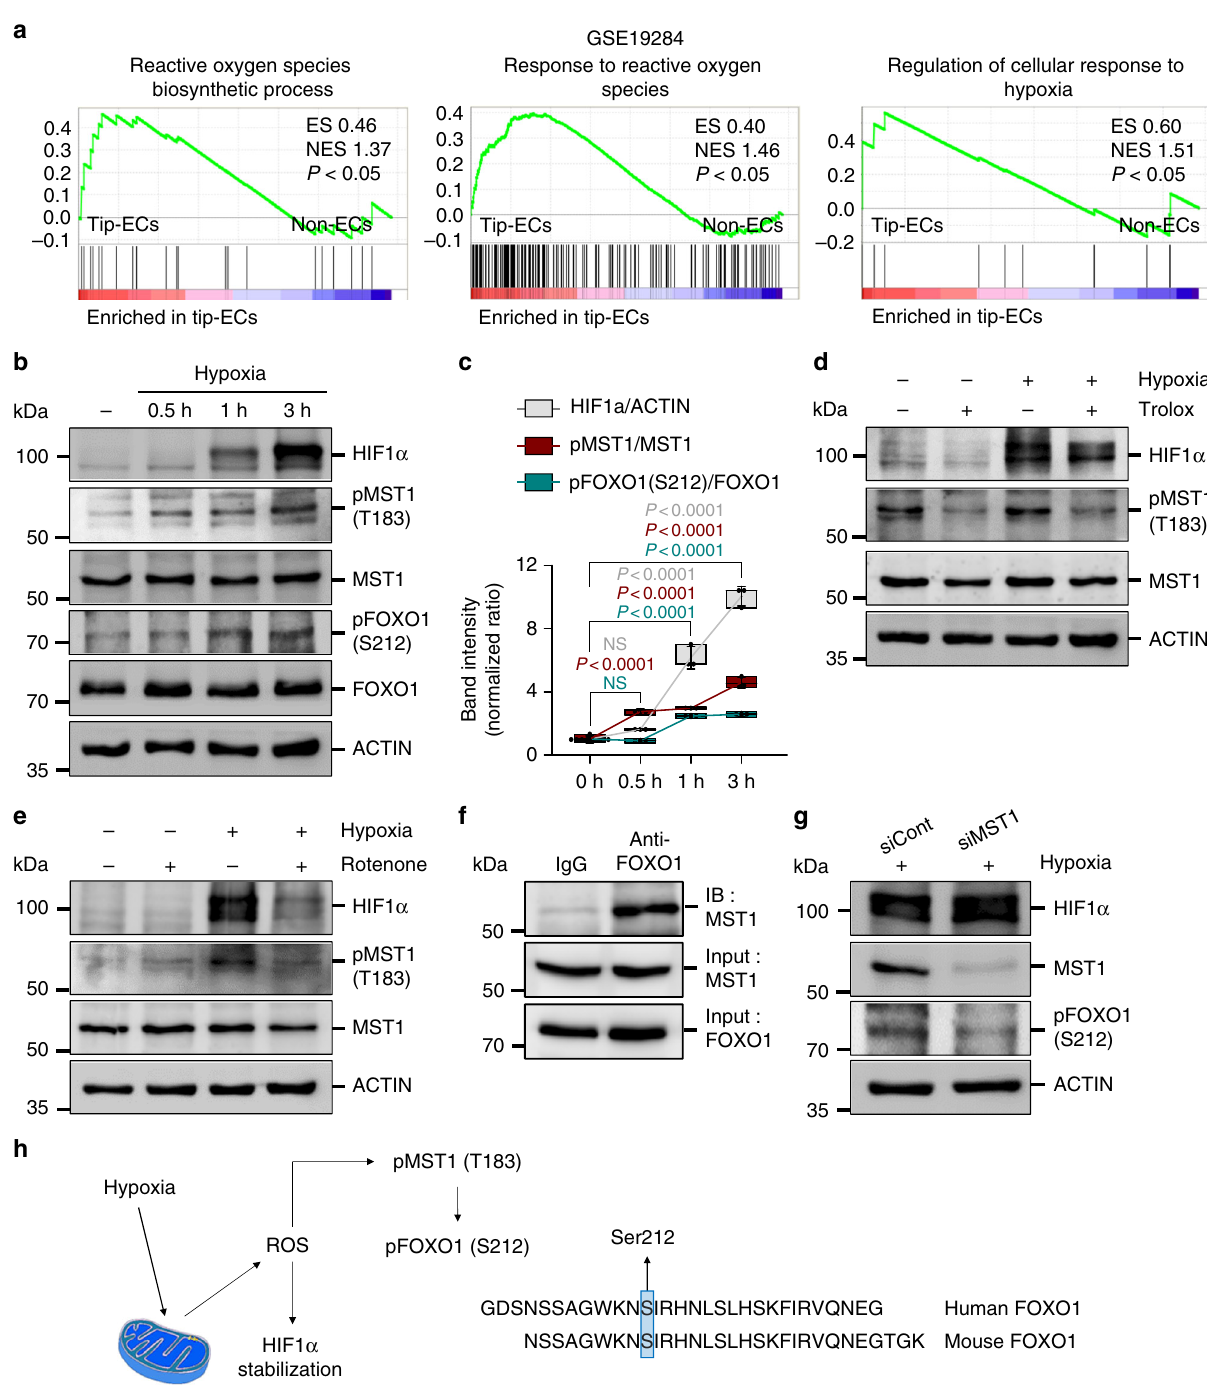
Fig. 5 Hypoxia activates the MST1 – FOXO1 cascade in primary cultured ECs. a GSEA analyses of the microarray data (GSE19284) obtained from isolated tip ECs and non-ECs by laser capture microdissection. b , c Immunoblot analyses and temporal changes of indicated proteins in HUVECs exposed to hypoxia (1% O 2 ) for indicated times ( n = 3, each group). Center line, median; Box limits, upper and lower quartiles; Whiskers, s.d. p values versus 0 h by one-way ANOVA with Tukey ’ s post hoc test. NS not signi fi cant. d Immunoblot analyses of indicated proteins in HUVECs under normoxia ( − ) and hypoxia ( + ) in absence ( − ) or presence ( + ) of Trolox treatment. e Immunoblot analyses of indicated proteins in HUVECs under normoxia ( − ) and hypoxia ( + ) in absence ( − ) or presence ( + ) of Rotenone treatment. f Immunoprecipitation analysis in HUVECs with control anti-IgG and anti-FOXO1 antibody followed by immunoblotting with anti-MST1 antibody. g Immunoblot analyses of indicated proteins in siCont-ECs and siMST1-ECs under hypoxia. h Schematic picture depicting a hypoxia-intracellular ROS – MST1 – FOXO1 cascade and the conserved phosphorylation site of FOXO1 by MST1. Source data are provided as a Source Data fi